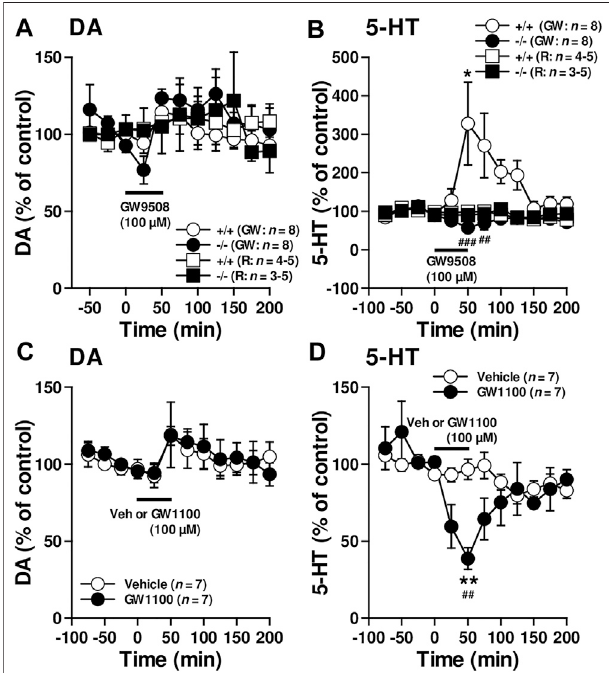
FIGURE2| Reciprocalcontrolofstriatal5-HTreleasebyFFAR1ligands. A FFAR1 agonist, GW9508, increased, but a FFAR1 antagonist, GW1100, decreased striatal 5-HT release withoutsigni fi cant changes striatal DArelease in FFAR1+/+ mice. However, the facilitatory effect of 5-HT release by GW9508 was completely lost in − / − mice. GW9508 (100 μ M) and GW1100 (100 μ M) were locally applied through a microdialysis probe as indicated by black lines. We also depicted control data from both +/+ and − / − mice by perfusing Ringer ’ s solution (R) during all experimental periods (A,B) . The fi gures show mean percentage changes from baseline DA (A,C) and 5-HT (B,D) values. * p < 0.05, ** p < 0.01 versus the basal values at time 0 min (Dunnett ’ s test). Two-way ANOVA with repeated measures indicated a signi fi cant effects of genotype [F (1, 154) (cid:2) 27.1, p < 0.001], time [F (10, 154) (cid:2) 2.21, p < 0.05], and genotype × time [F (10, 154) (cid:2) 3.93, p < 0.01] in the facilitatory in fl uence of GW9508 on 5-HT release (B) , and a signi fi cant effects of treatment [F (1, 140) (cid:2) 5.41, p < 0.05], time [F (11, 140) (cid:2) 3.94, p < 0.001], and treatment × time [F (11, 140) (cid:2) 2.90, p < 0.01] in the inhibitory action of GW1100 on 5-HT release (D) . The post hoc tests showed that GW9508-induced enhanced 5-HT releases were signi fi cantly suppressed at 50 and 75 min time points in − / − mice, whereas GW1100 signi fi cantly reduced 5-HT release at 50 min time point in+/+ mice. ## p < 0.01, ### p < 0.001vs. +/+ miceor vehicle control (Turky-Kramer